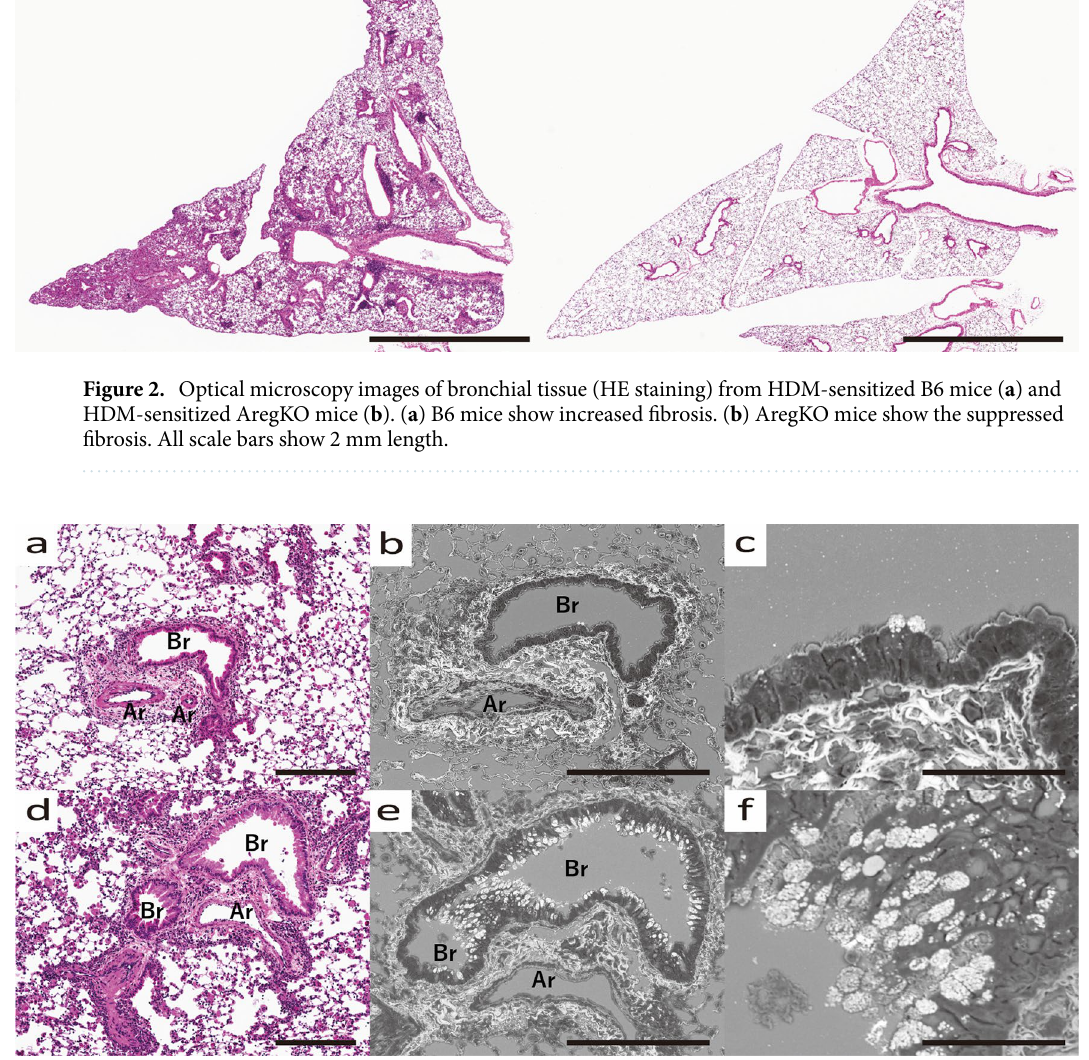
Figure 3. Morphological changes of pulmonary tissue in HDM-sensitized B6 mouse. ( a ) Optical microscope image of Bronchi (Br) and accompanying blood artery (Ar), HE stained. ( b ) SEM image of Br and Ar, Grocott stained. EM, 10kv, 2.5 nm. ( c ) Magnified SEM image of Br and Ar. ( d ) Optical microscope image of another Br and Ar, HE stained. ( e ) SEM image of Br and Ar, Grocott stained. f) Magnified image of Br and Ar. ( a – c ) HDM- sensitized B6 mouse developed fibrosis surrounding the entire bronchus, especially near the artery, and mucus production only from the same area. ( d – f ) Mucus vesicles are being produced from bronchial epithelial cells. All scale bars show 200 μm